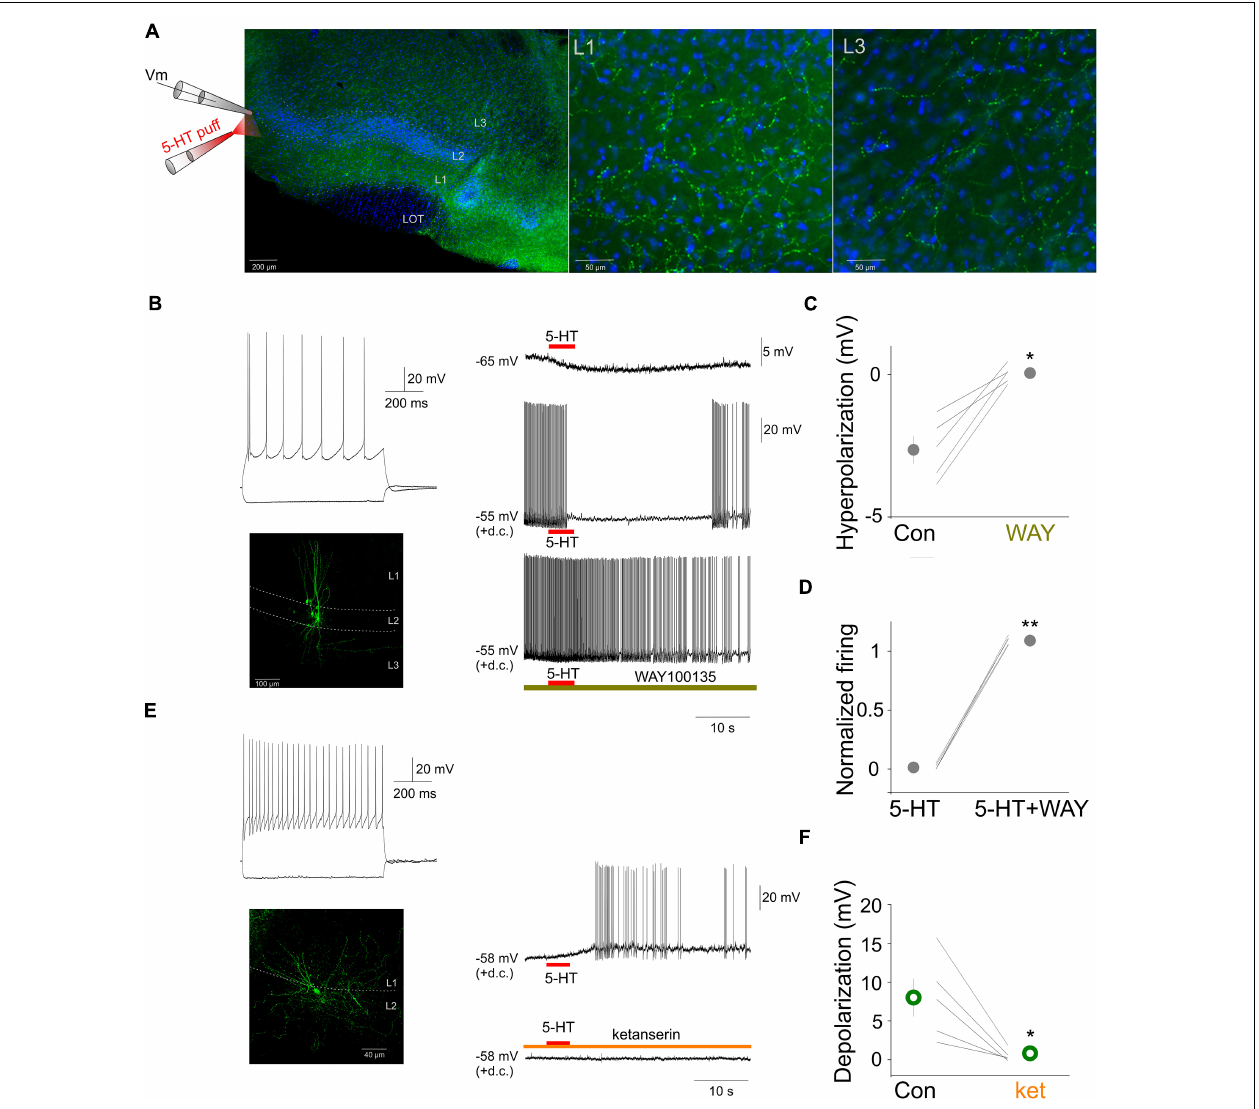
FIGURE 1 | Focal 5-HT application suppresses the activity of principal neurons and increases the activity of interneurons in the aPC. (A) Schematic of the experimental design and serotonergic axonal innervation (green channel: serotonin immunopositive fibers) of the aPC. Coronal section of a mouse brain at the level of the aPC. The lateral olfactory tract (LOT) and the three layers of the aPC are indicated. Blue channel: DAPI staining. Higher magnification images of layers 1 and 3, respectively are shown on the right side. (B) Membrane responses to hyperpolarizing and depolarizing current steps (top left), morphology (bottom left) and effect of focally applied 5-HT (100 µ M, middle) of a principal neuron at resting membrane potential and during periods of action potential firing (+d.c.). The 5-HT1a antagonist WAY100635 (1 µ M) prevented the suppressive effects of 5-HT. (C) Effects of focally applied 5-HT in ACSF (Con) and WAY 100635 (WAY) on all recorded aPC principal neurons ( n = 5). (D) Normalized firing rates of all recorded principal neurons ( n = 5) during focal 5-HT application in the absence and presence of WAY 100635 (WAY), respectively. (E) Membrane responses to hyperpolarizing and depolarizing current steps (top left), morphology (bottom left) and effect of focally applied 5-HT (100 µ M, middle) of an aPC interneuron. The 5-HT2 antagonist ketanserin (10 µ M) prevented the depolarizing effects of 5-HT. (F) Effects of focally applied 5-HT in ACSF (Con) and ketanserin (ket) on all recorded aPC interneurons ( n = 5). * p < 0.05, ** p < 0.01.